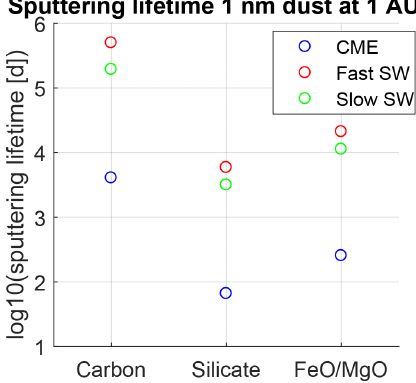
Figure 5. Sputtering lifetimes for carbon (dashed), silicate (solid), and Fe 0 . 4 Mg 0 . 6 O (dotted) dust particles at 1AU for different sizes; line colour indicates plasma environment (blue – CME conditions, green – slow solar wind, red – fast solar wind). Collisional lifetime ( τ C ) and Poynting–Robertson lifetime ( τ PR ) are shown in black for comparison (data taken from Grün et al.,